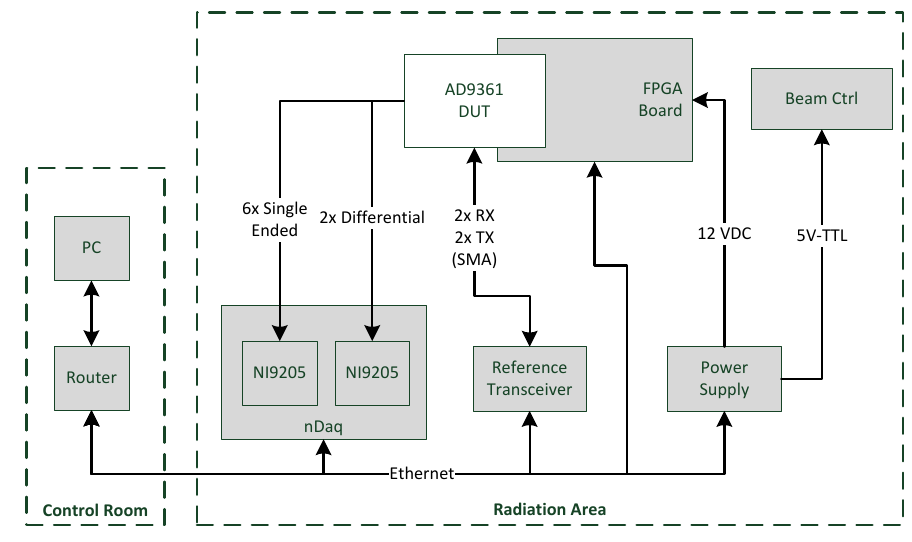
Figure 4. Schematic of the SEE test setup.